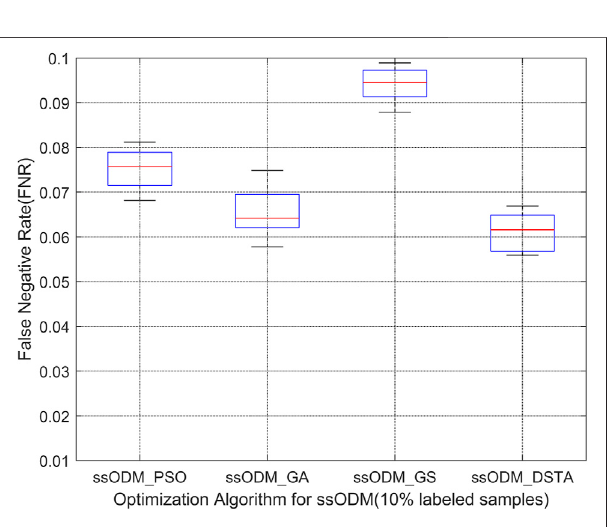
FIGURE 6 | Boxplot of FNR of fault detection regarding the pitch emergency stop (10% labeled samples).